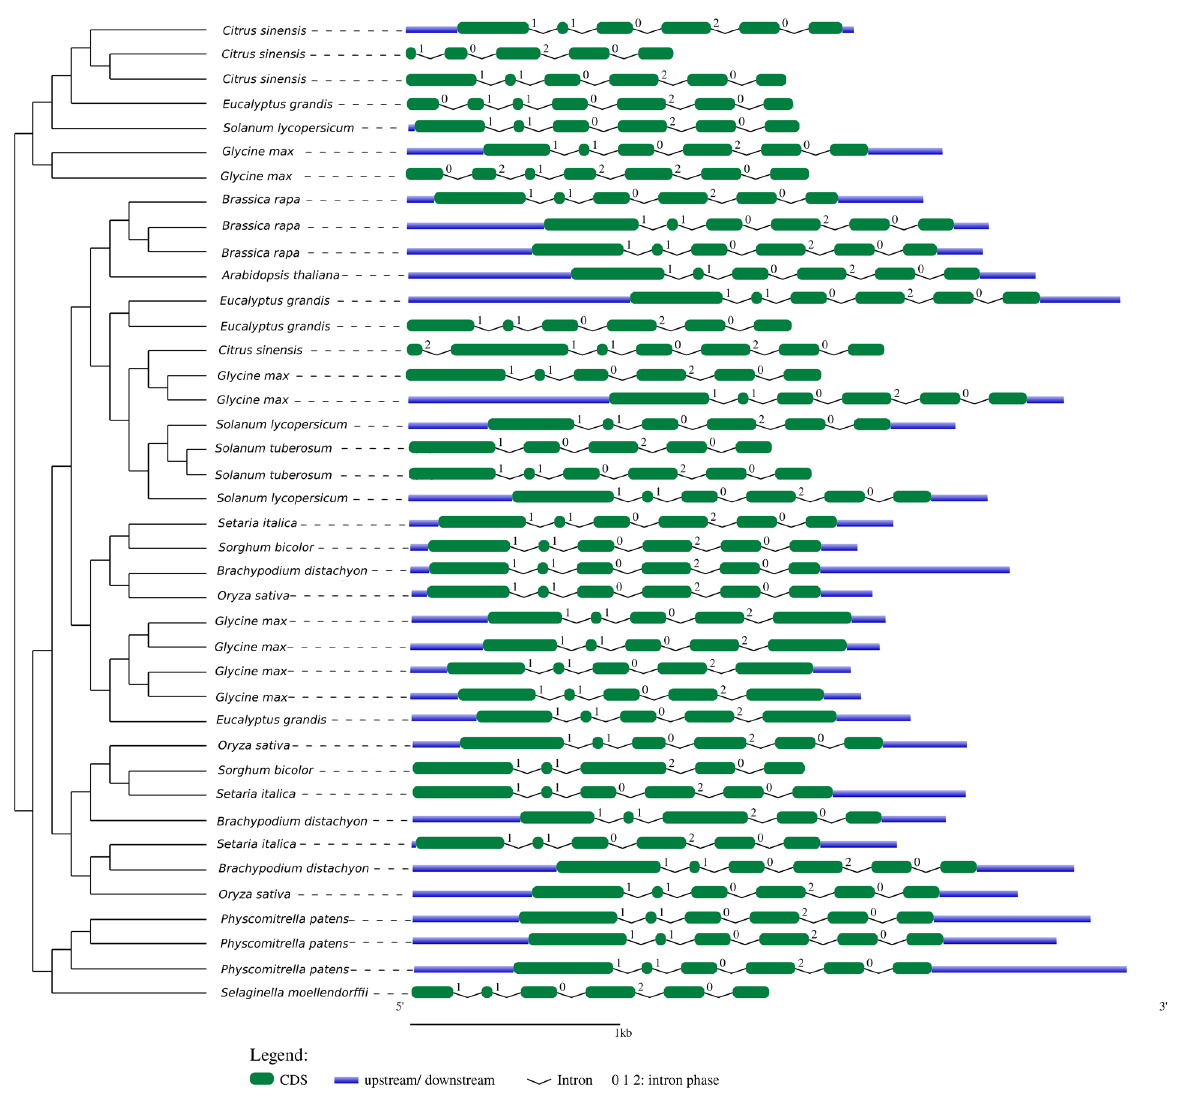
Figure 2 – Exon-intron organization of PSY genes in terrestrial plants. PSY sequences from 13 representative species ( Physcomitrella patens , Selaginella moellendorffii , Brachypodium distachyon , Setaria italica , Oryza sativa , Sorghum bicolor , Solanum lycopersicum , Solanum tuberosum , Eucalyptus grandis , Citrus sinensis , Arabidopsis thaliana , Brassica rapa , Glycine max ) are presented. Gene features are displayed on a Bayesian phylogenetic